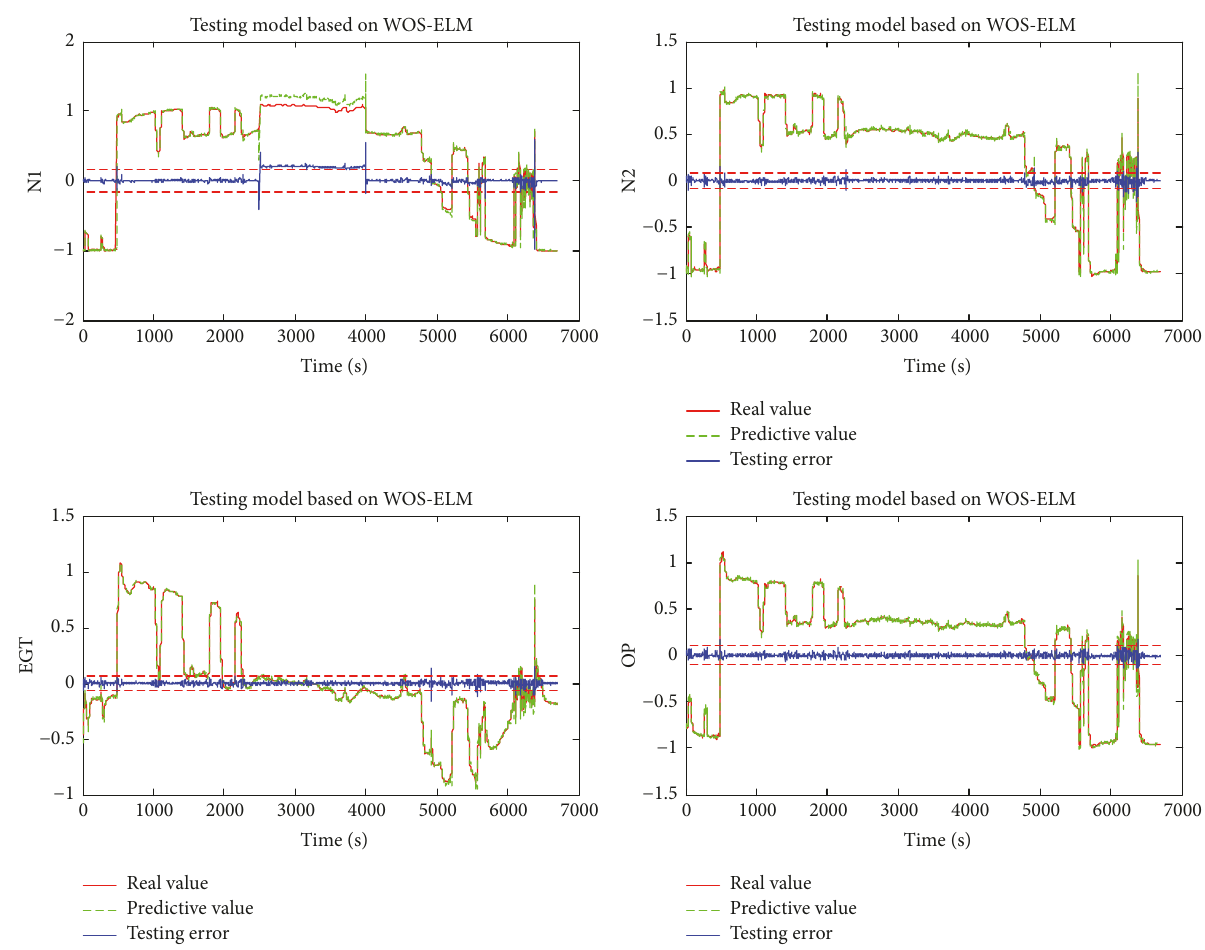
Figure 7: Results of time redundancy submodels for step fault of N1.